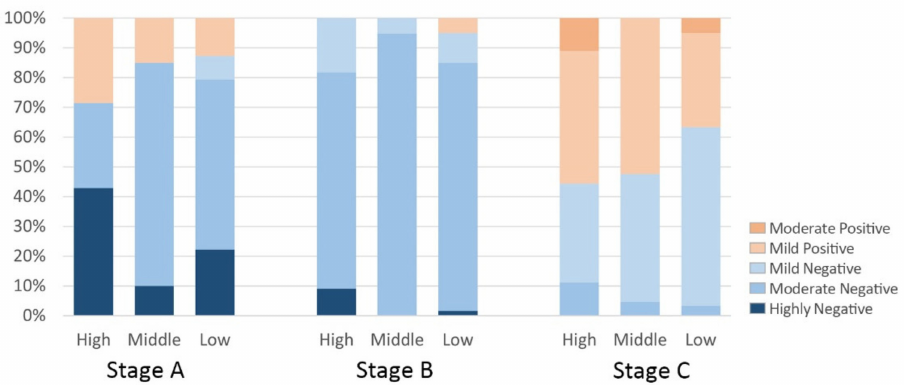
Figure 11. Percentage of each type of sentiment in high, medium and low medical